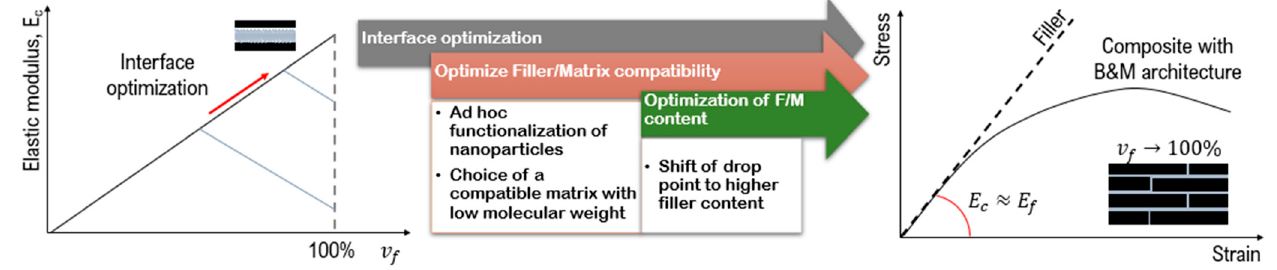
Figure 13. Strategies to optimize the mechanical properties of high filler content composites.